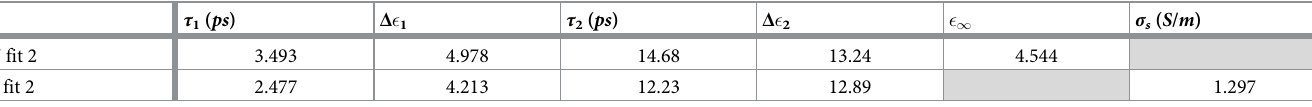
Table 3. Parameters for Debye curves, with two (fit 2) and with one (fit 1) relaxation. τ 1 ( ps